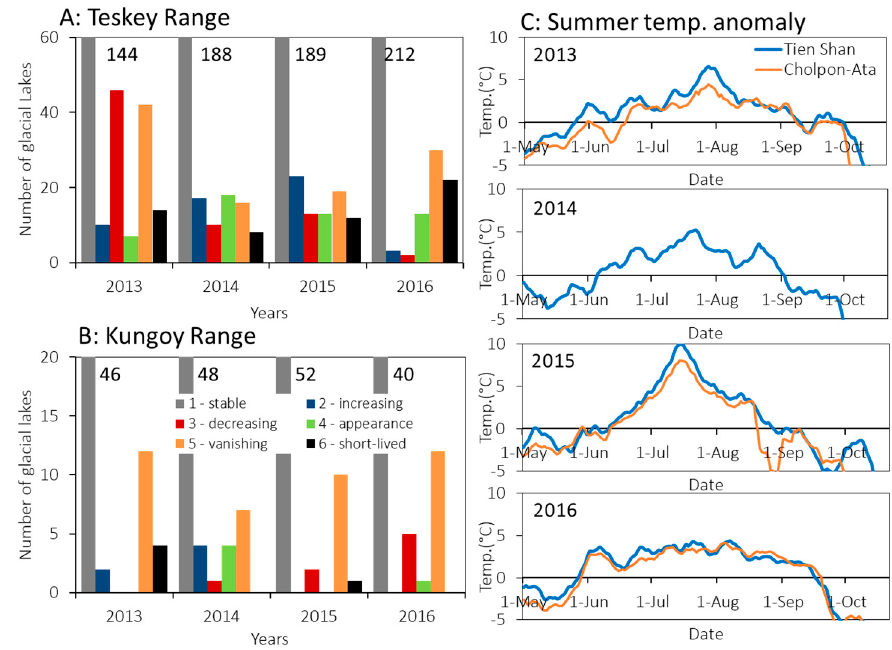
Figure 2. Number of lakes in the six types and the summer temperature anomaly in the Issyk-Kul Basin during 2013–2016. ( A ) Teskey Range. ( B ) Kungoy Range. The value next to the grey bar shows the number of “stable” lakes. ( C ) Eleven-day running means of summer temperature (May–October) anomaly during 2013–2016 at the Tien Shan (Teskey Range) and Cholpon-Ata (Kungoy Range) meteorological stations (for locations, see Figure 1). For these six months, the average temperatures of the Tien Shan meteorological station were 2.4 °C in 2013, 1.5 °C in 2014, 2.5 °C in 2015, and 2.1 °C in 2016, whereas those for the Cholpon-Ata meteorological station were 15.8 °C in 2013, 15.5 °C in 2015, and 15.3 °C in 2016.